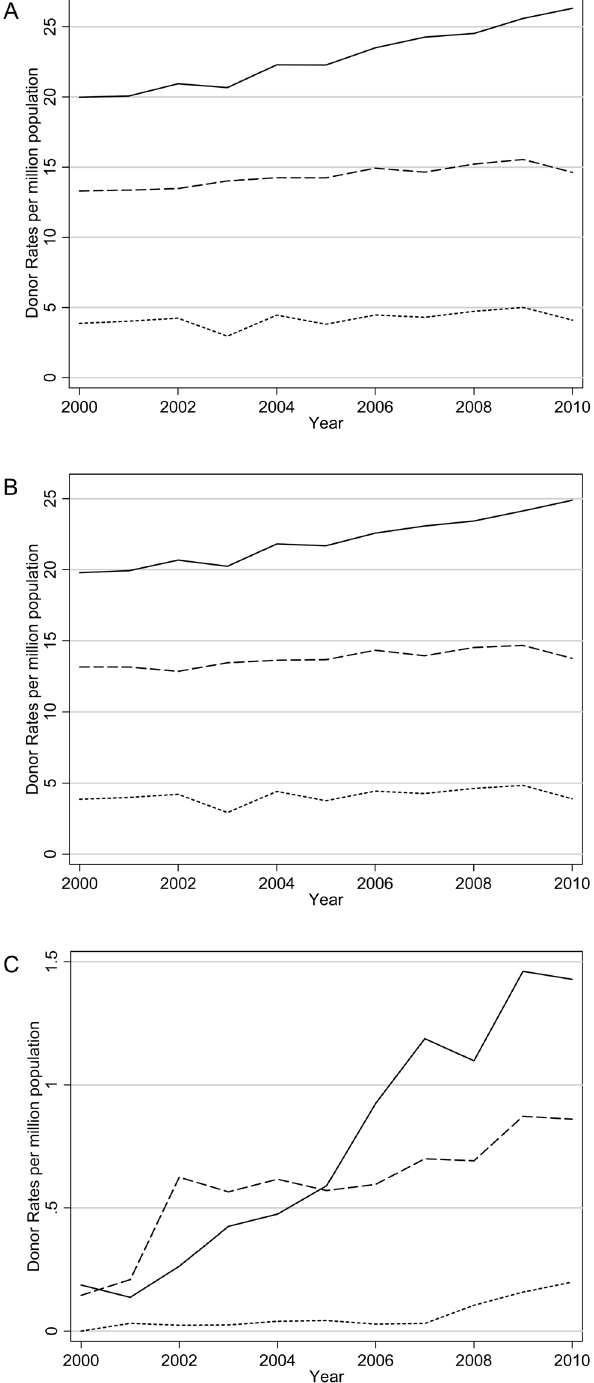
Figure 2. Average (a) Deceased Donors (DD), (b) Donation after Brain Death (DBD) and (c) Donation after Cardiocirculatory Death (DCD) rates over time by Group One (solid line), Group Two (dashed line) and Group Three (dotted line) countries.